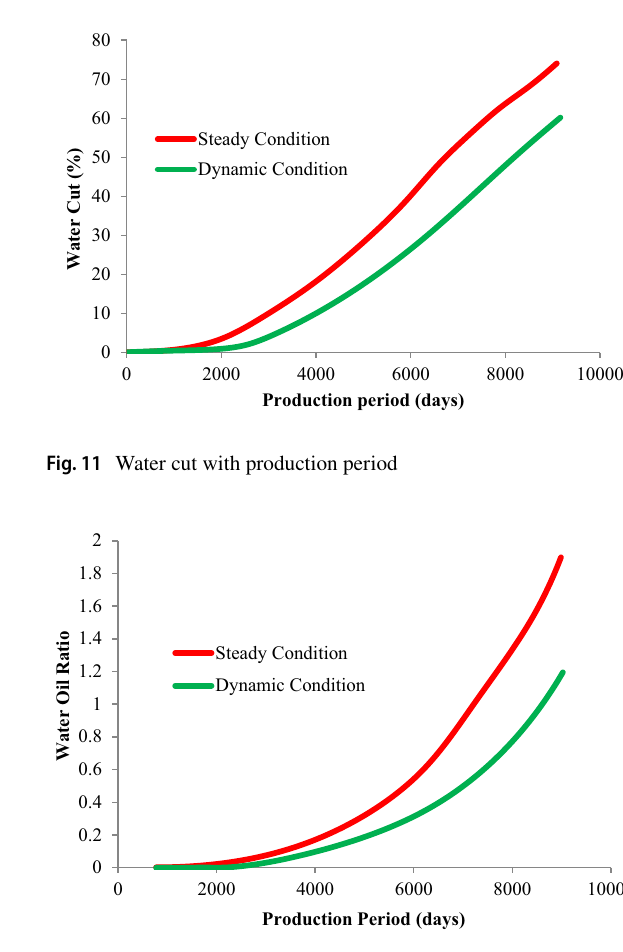
Fig. 12 Water–oil ratio with production